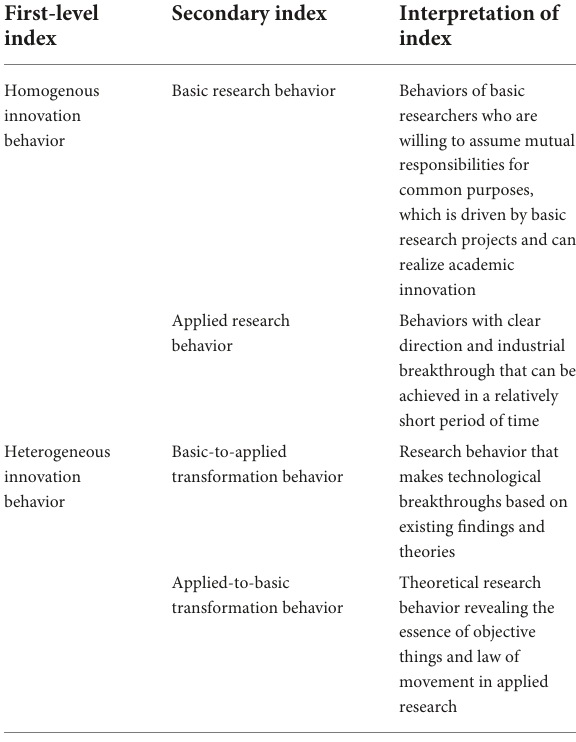
TABLE 2 Index system of innovation